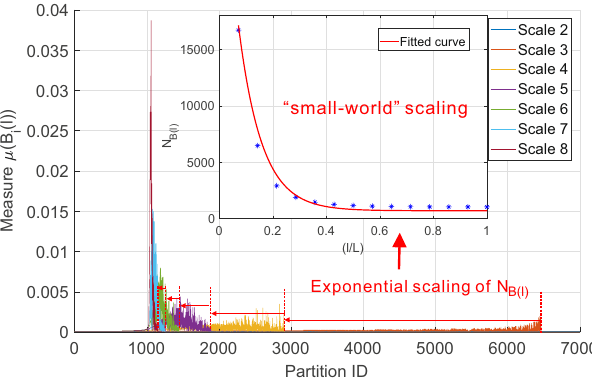
Figure 16. The fundamental impact of link weights on the multi-fractality of network. We keep the exactly same structure of the collaboration network but remove all its weights to transform the network into a binary network. We performed the proposed box-covering method to measure the scaling dependence of number of boxes and the distribution of their associated measure. Figure shows the loss of multi-fractality as a result of removal of link weights. Instead, we notice it the scaling dependence is best explained by an exponential law ( a * exp ( bx ), a = 3.75 * 10 4 , b = − 11.55) suggesting the unweighted collaboration network becomes a “small- world” network.